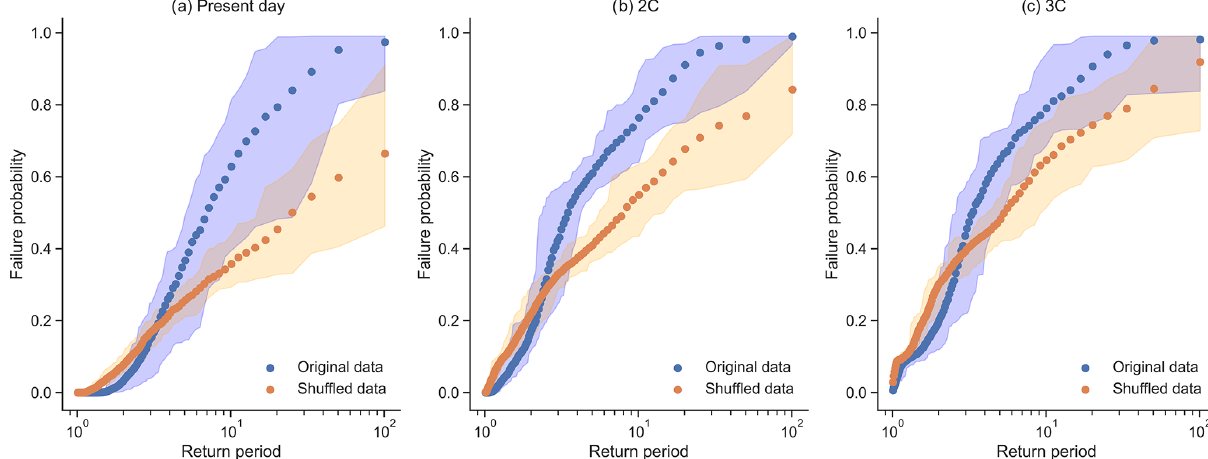
Figure 6. Random forest model failure probabilities for different return periods, based on original data (variable correlations as normal, blue) and shuffled data (variable correlation removed, orange) for three climatic periods: (a) present-day, (b) pre-industrial + 2C warming and (c) pre-industrial + 3C warming. Dots show the 20-member mean; shading shows the envelope of variability for the grouped